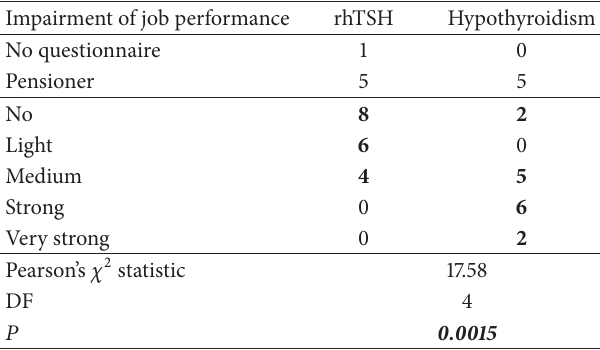
Impairment of job